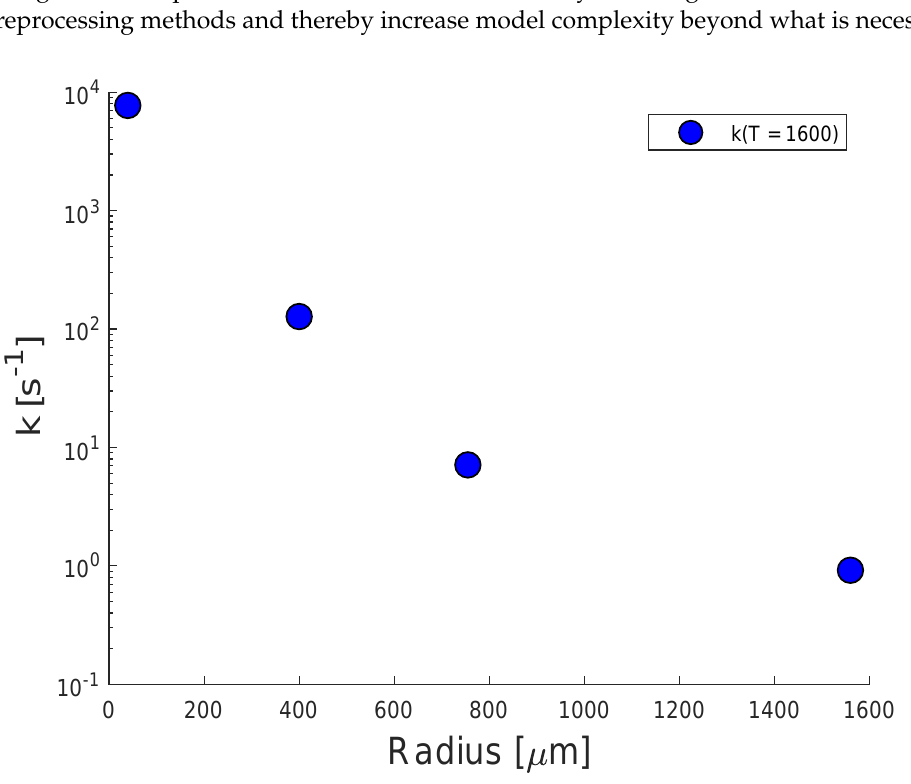
Figure 4. Reaction rate as a function of initial particle radius for particles simulated with the semi-2D code with ρ = 700 kg/m 3 , AR =